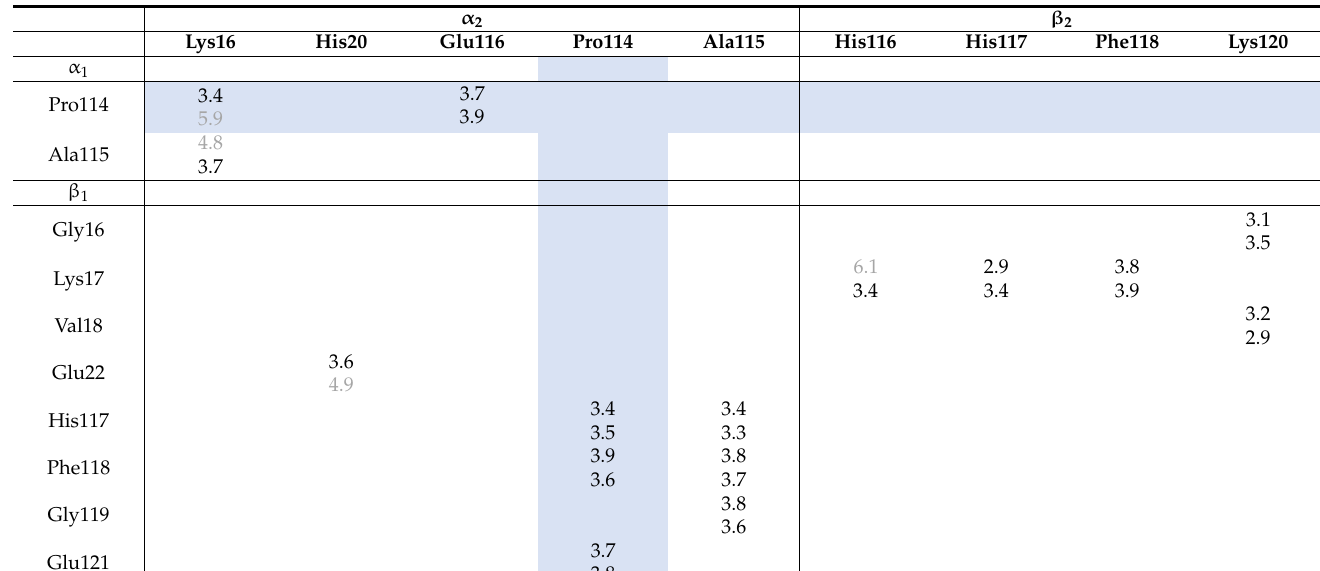
Table 2. Double strand axial contact distances < 4.0 Å [3]. The two entries refer to the two non- equivalent molecules in the double strand, with the gray entries those that are greater than 4.0 Å. For the atomic details of the contacts, the reader is referred to the original work [3]. The contacts of Pro α 114 are